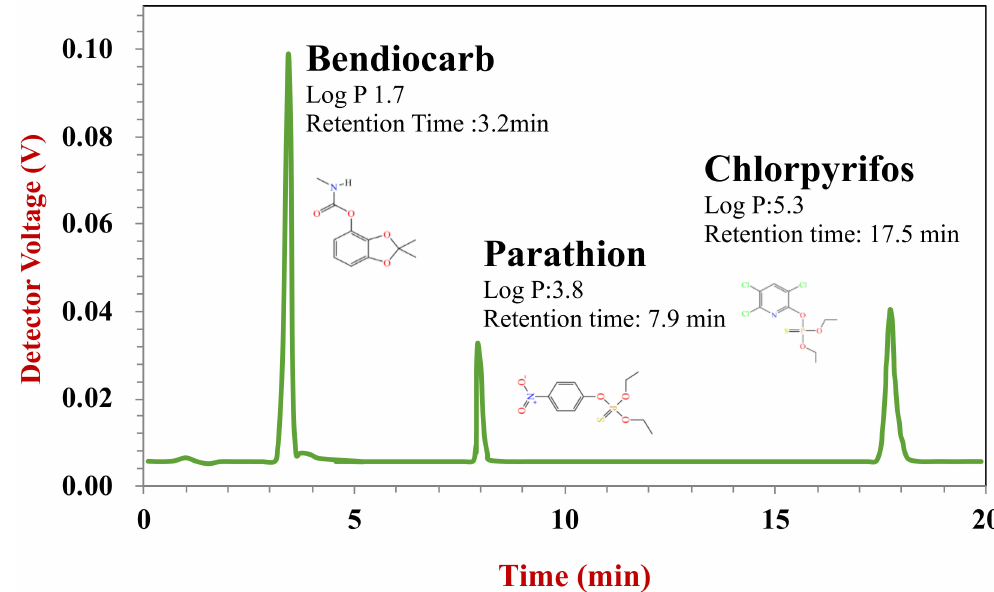
Figure 7. HPLC chromatogram of mixed pesticides standard. Key to peak identity: 1, bendiocarb; 2, parathion; and 3,